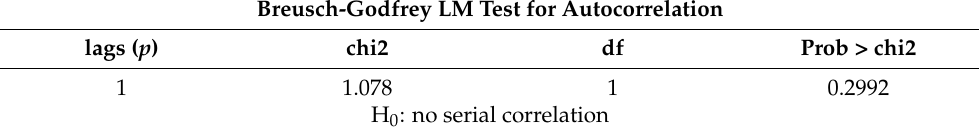
Table A3. Autocorrelation test